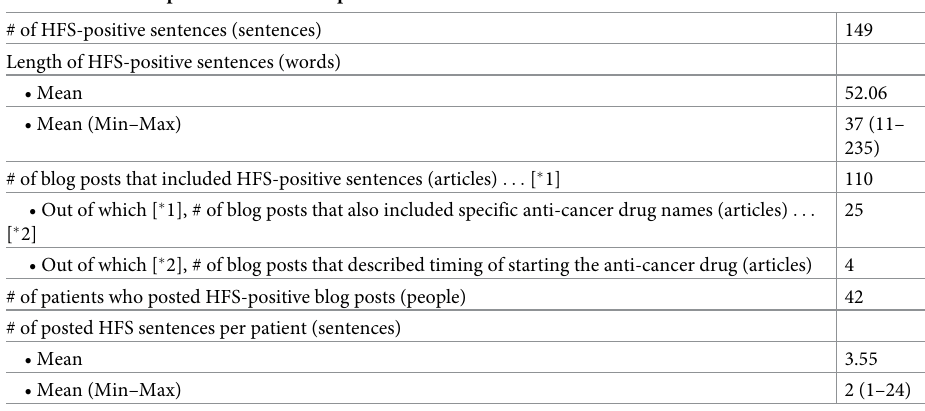
Table 3. Statistical parameters for HFS-positive